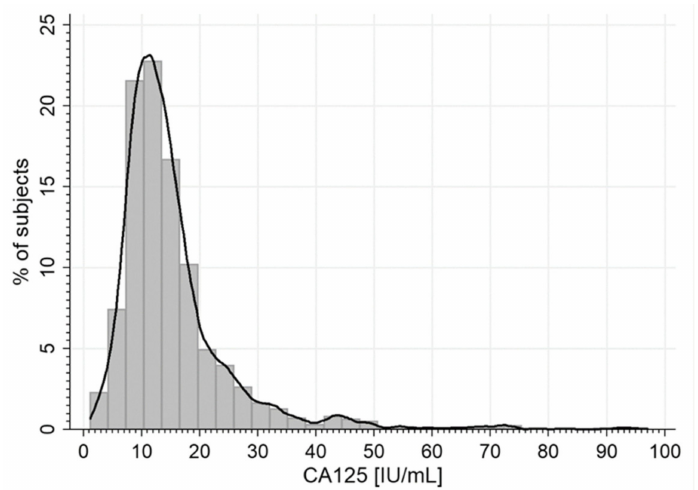
Figure A1. Study flow.